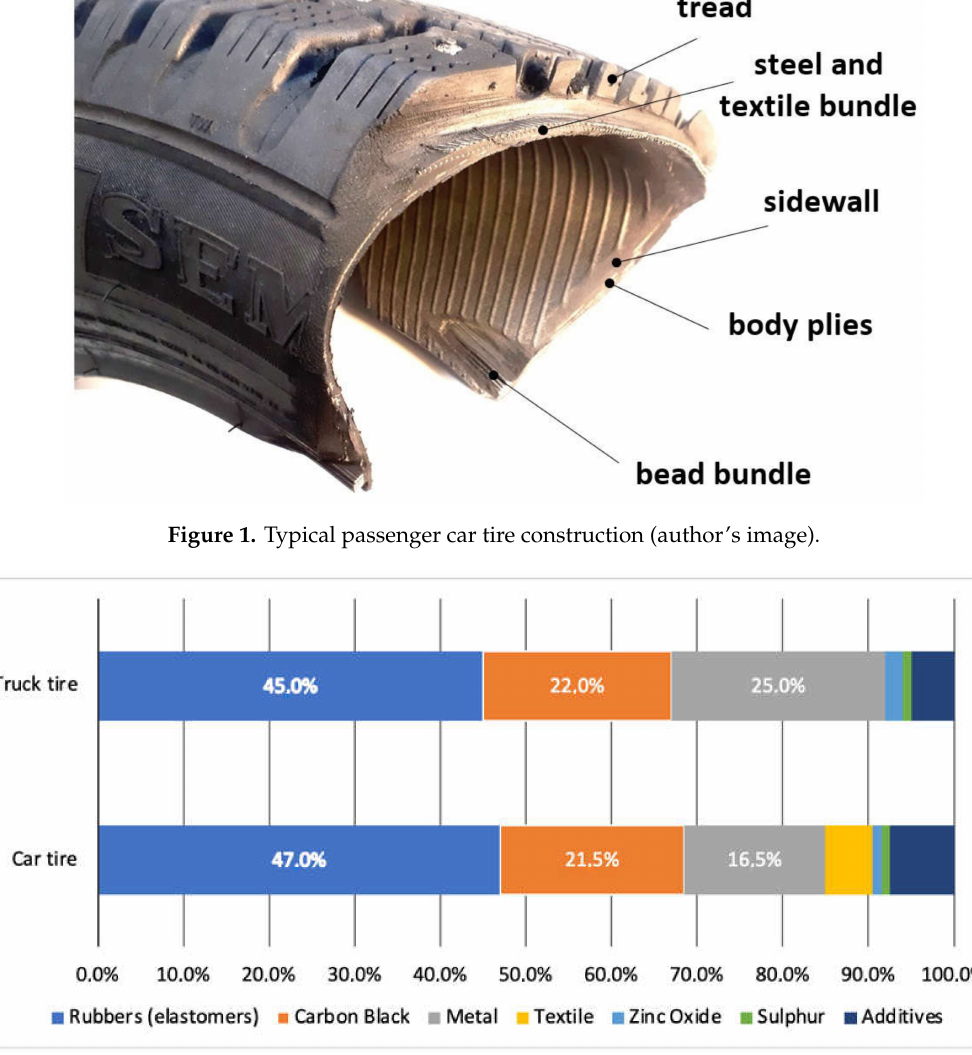
Figure 2. Typical composition of passenger and truck tires, wt%.